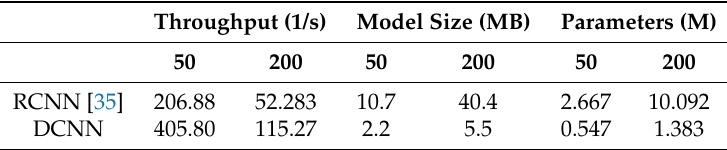
Table 7. On-device throughput and size of the models.